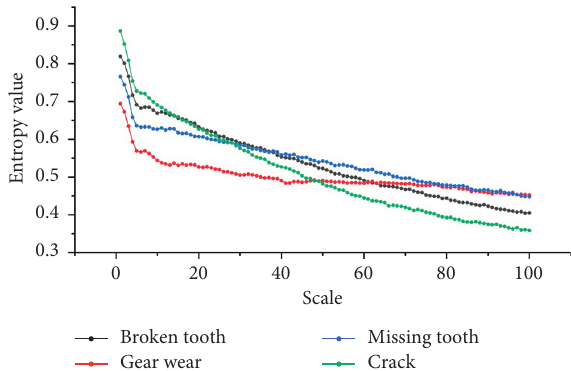
Figure 13: The calculated PE value of the signal varies with t